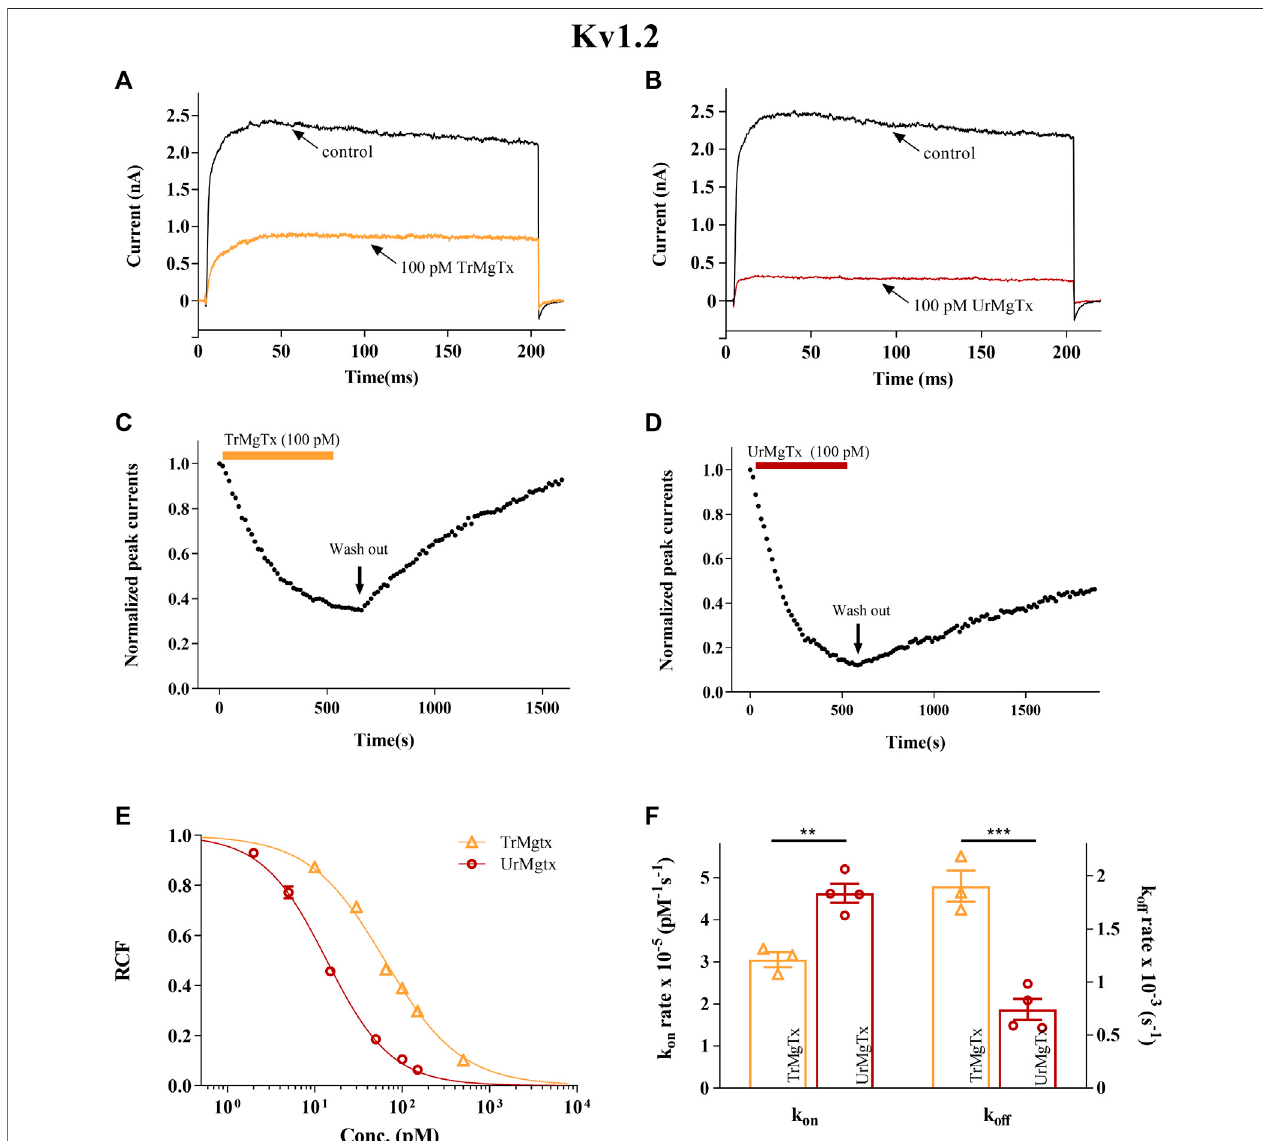
FIGURE 7 | Inhibition of hKv1.2 currents by tagged and untagged recombinant MgTx. (A,B) The K + currents through hKv1.2 were evoked from transiently transfected CHO cells either in whole-cell or outside-out patch con fi guration by depolarization to +50 mV from a holding potential − 120 mV for 200 ms duration. Test pulses were applied every 15 s. Representative traces show the K + current before the application of toxin (control) and after reaching the equilibrium block in the presence TrMgTx (A) or UrMgTx (B) in 100 pM concentration (as indicated). (C,D) Development of and recovery from block of hKv1.2 current. Normalized peak currents were measured in whole-cell patch con fi guration and plotted against time as100 pM of either TrMgTx (C, yellow bar) or UrMgTx (D, burgundybar) was applied to the bath solution. Following block equilibrium, the recording chamber was perfused with toxin-free solution (arrow, washout) to assess reversibility of the block. (E) Concentration-dependent block ofhKv1.2 byTrMgTx and UrMgTx. TheRCF values taken at differenttoxin concentrationswere fi ttedwith athree-parameter(inhibition) vsresponsemodel(seetheMaterialsandMethodssectionfordetails).Thebest fi tyielded K d (cid:1) 14 pMforUrMgTxand K d (cid:1) 64 pMforTrMgTx.ErrorbarsrepresentSEM and n (cid:1) 3 – 5. (F) ComparisonofblockkineticsofTrMgTxandUrMgTxforhKv1.2.Associationrateconstant k on (lefty-axis)anddissociationrateconstant k off (righty-axis) were calculated from measured time constants ( τ on , τ off ) for the development of the block in the presence of 100 pM toxin and the washout (see C and D ), assuming a simplebimolecularreactionbetweenthechannelandtoxin(seetheMaterialsandMethodssectionfordetails)andplottedonbargraph.Symbolsindicateindividualdata points ( n (cid:1) 3 – 4), bar heights and error bars indicate mean ± SEM. ** p < 0.01, *** p < 0.001, ns (cid:1) not signi fi cant, unpaired t test comparison.